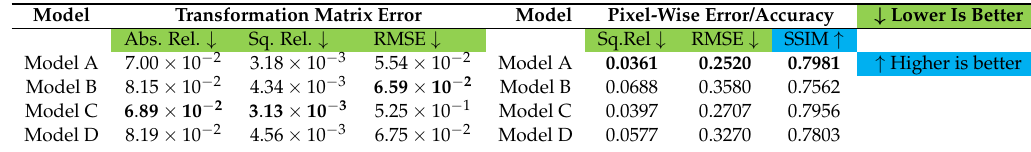
Table 4. Accuracy metrics of network variants. Best performance in bold.